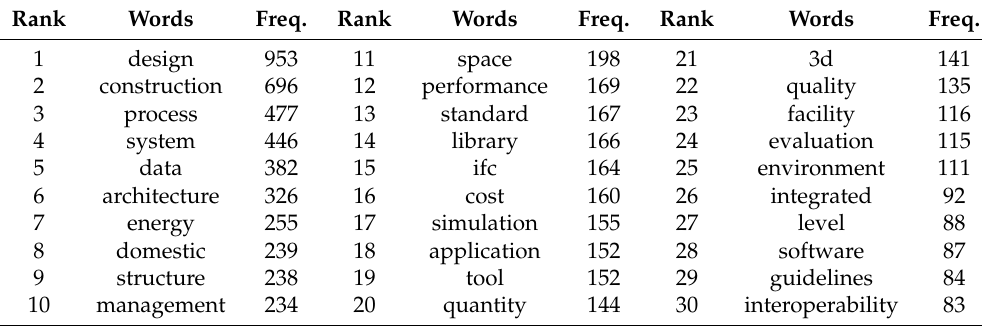
Table 3. Frequency analysis (Total, Top 30).